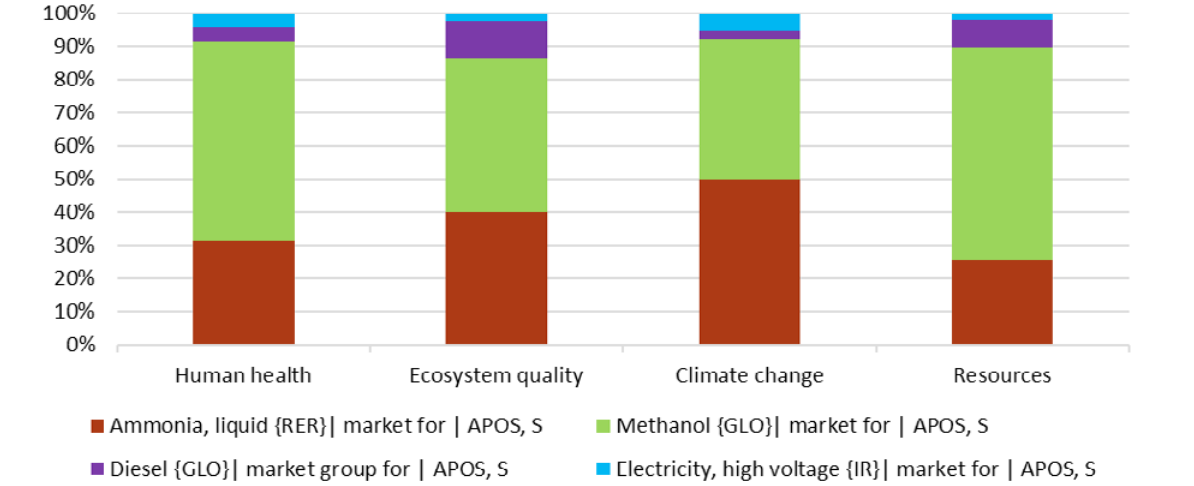
Figure 12. Results of impact 2002+ method in damage calculation